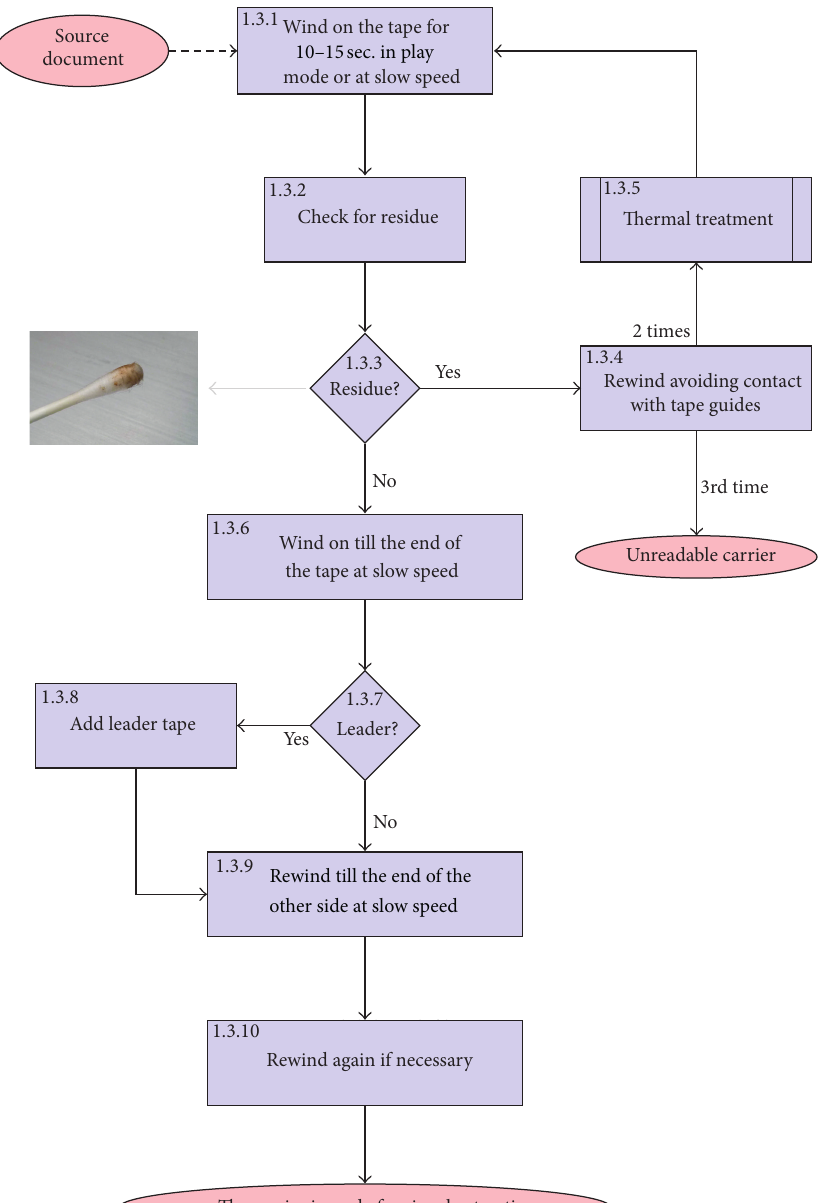
Figure 6: Flowchart of a subprocedure of step 1.2 “Optimization of the carrier”, where among other things the presence of Soft Binder Syndrome-Sticky Shed Syndrome (SBS-SSS) is